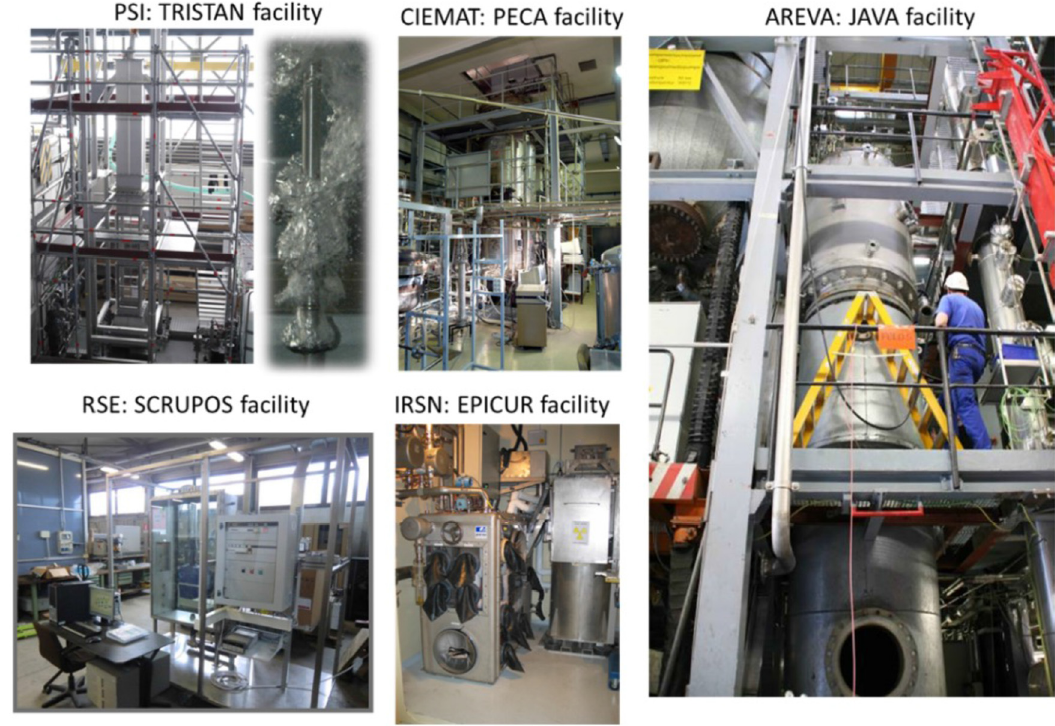
Fig. 1. Some selected PASSAM experimental